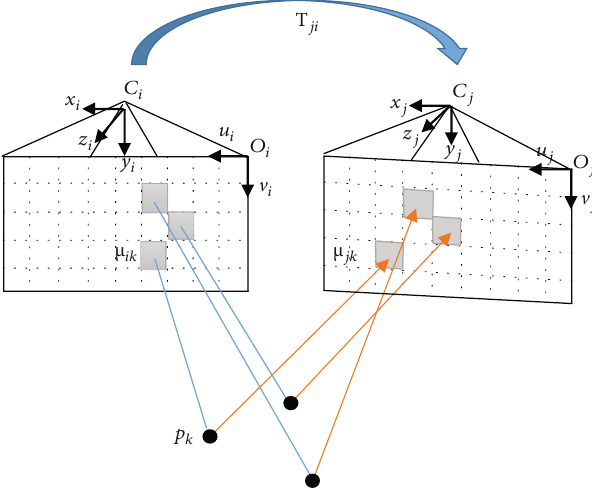
Figure 1: Schematic diagram of the relationship between the pixels on the image i and the image j and their projection